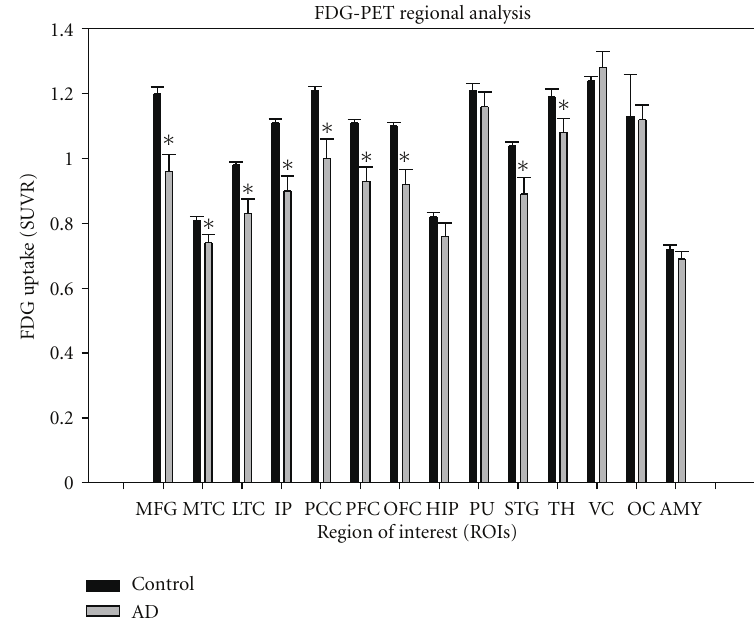
Figure 2: Regional FDG uptakes in normal control subjects and Alzheimer’s disease (AD) patients. Mean and SE of relative standardized uptake values (SUVRs) for FDG-PET in various brain regions in normal (black bars) and AD subjects (gray bars). MFG: middle frontal gyrus, MTC: medial temporal cortex, LTC: lateral temporal cortex, IP: inferior parietal lobe, PCC: posterior cingulate cortex, PFC: prefrontal cortex, OFC: orbitofrontal cortex, HIP: hippocampus, PU: putamen, STG: superior temporal gyrus, TH: thalamus, VC: visual cortex, OC: occipital cortex, AMY: amygdala. ∗ P < . 05, two-tailed t test.